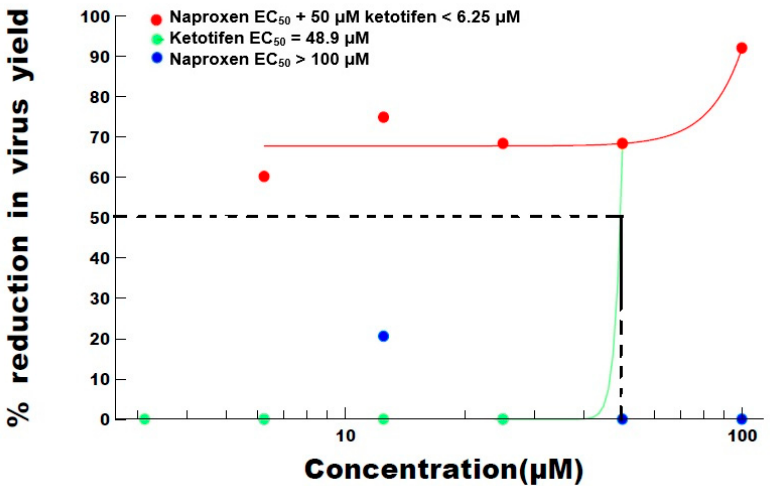
Figure 2. Dose–response curves for naproxen and ketotifen, alone and in combination. EC 50 is the effective concentration of product, i.e., the concentration at which virus infection is inhibited by 50 percent.